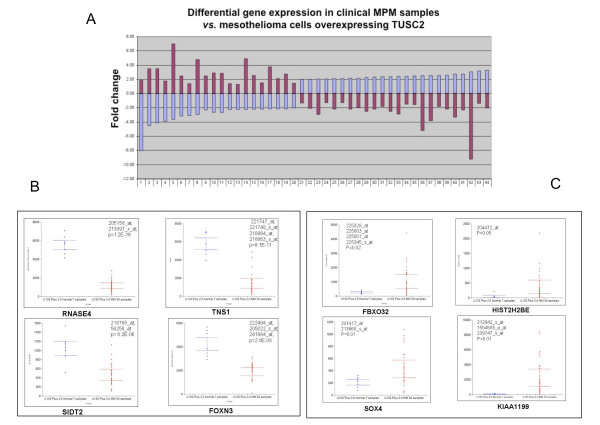
Opposite directions of TUSC2 targets modulation in HP2595/TUSC2 versus mesothelioma tumors. A. Graph shows fold change expression of 44 genes in mesotheliomas as opposed to MPM cells overexpressing TUSC2. Expression changes in mesothelioma are shown with red bars while in HP2595 cell line with blue bars. Only statistically significant modulation in mesothelioma as compared to normal peritoneum (p < 0.05) is shown. Gene names that correspond to numbers in the bottom are provided in Table 4. B. Representative plots for genes down-regulated in mesothelioma with high p-value, but upregulated by TUSC2. C. Representative plots for genes upregulated in mesothelioma with high p-value, but down regulated by TUSC2. Each plot shows Affymetrix IDs for each gene probes and respective p-value.